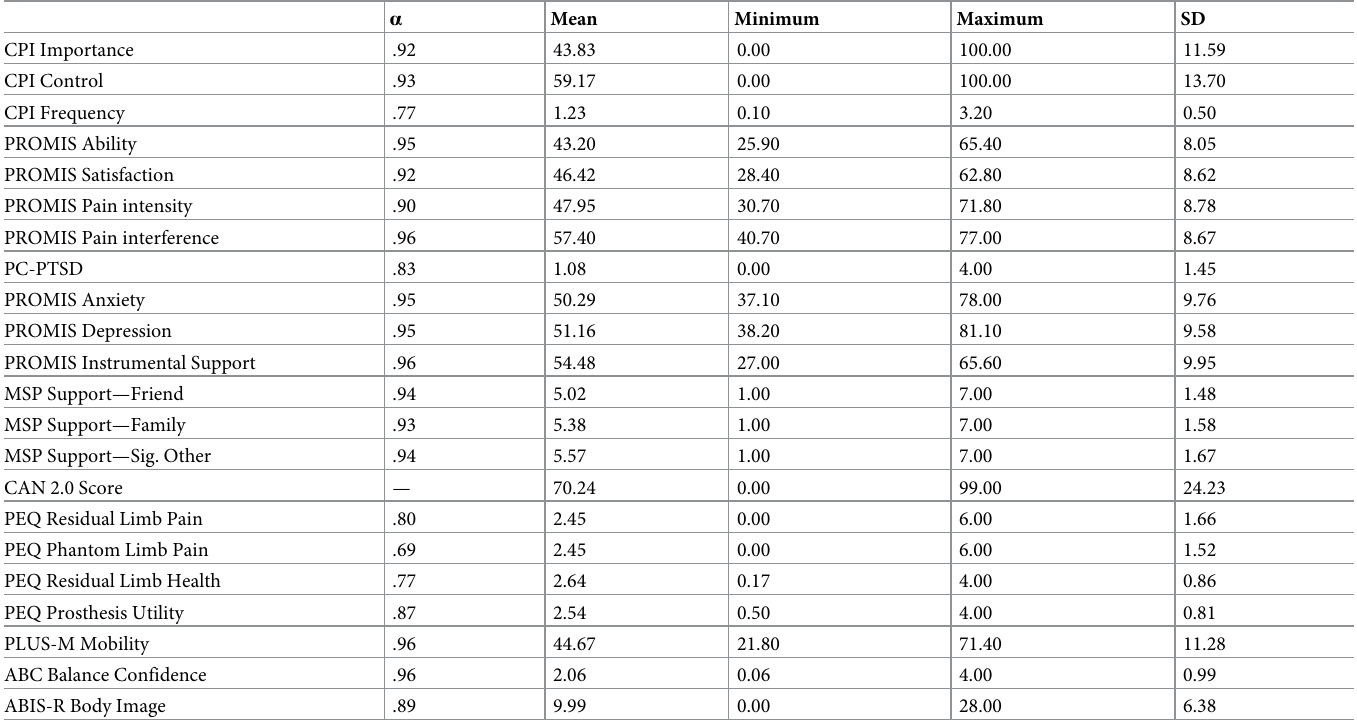
Table 2. Descriptive statistics for study